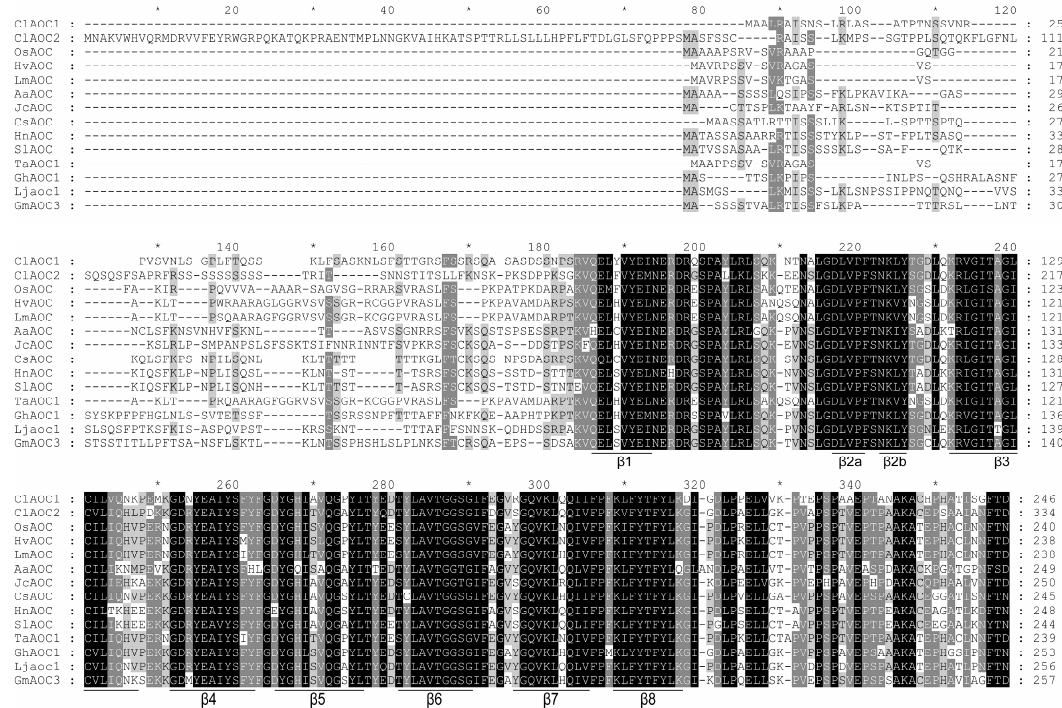
Figure 2. Alignment of the deduced amino acid sequence of ClAOC1 and ClAOC2 with other AOC proteins from different plant species. The eight β -strands are underlined. The accession numbers of AOC proteins are as follows: JcAOC, ACZ06580.1; OsAOC, ABV45432.1; HnAOC, AAU11327.1; AaAOC, ADL16493.1; SlAOC, CAC83760; TaAOC1, AHA93095.1; GhAOC1, ALG62635.1; LmAOC, AFP87304.1; CsAOC, ADY38579.1; GmAOC3, AEE99198.1; HvAOC, CAC83766.1; Ljaoc1, AB600747.1.